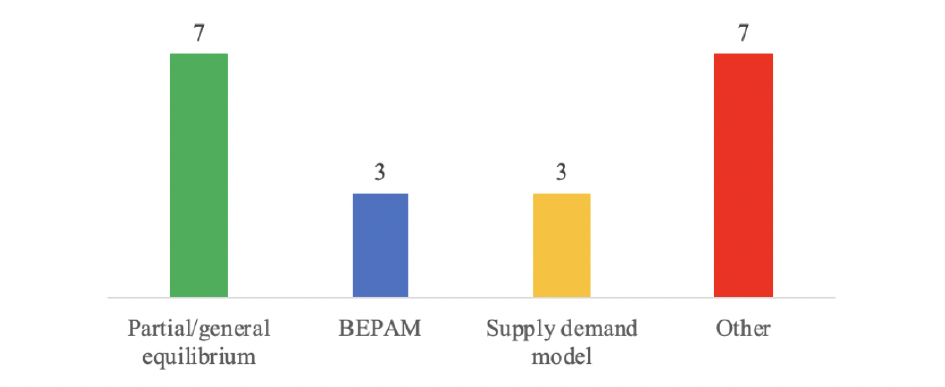
Figure 14. Count of models used in the